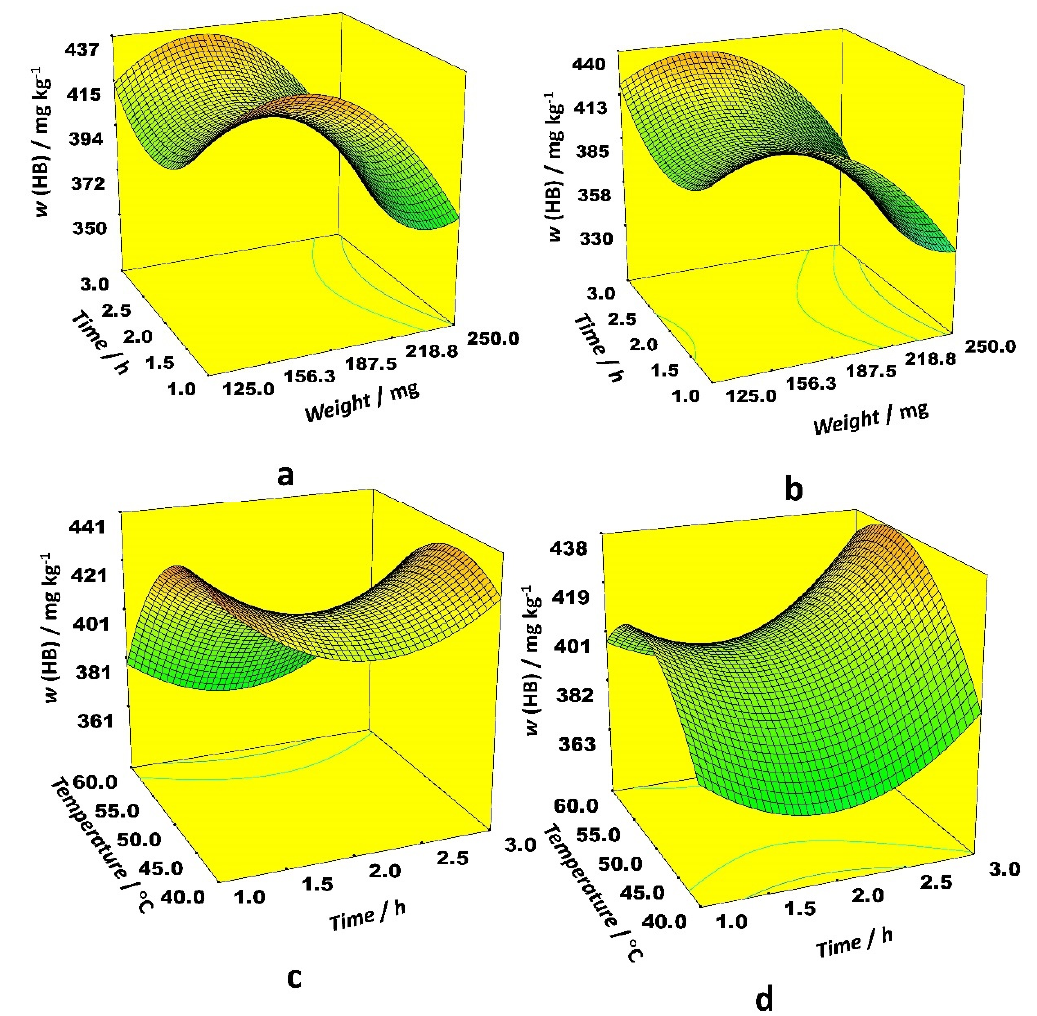
Figure 4. 3D response surface plots of the most prominent interaction factors for hydroxybenzoic acids extracted from grapevine leaves using ethanol (subfigures a , c ) and acetonitrile (subfigures b , d ) as organic modifiers.